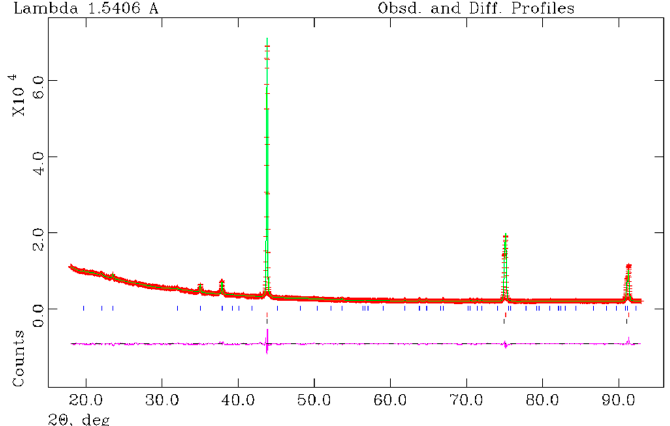
Figure 4. X-ray Rietveld refinement of the sample N1. The observed (+), calculated (solid line) and difference between observed and calculated (bottom curve) powder diffraction profiles. The positions of all allowed Bragg reflections are indicated by the rows of vertical tick marks: B 4 C upper and diamonds lower marks.